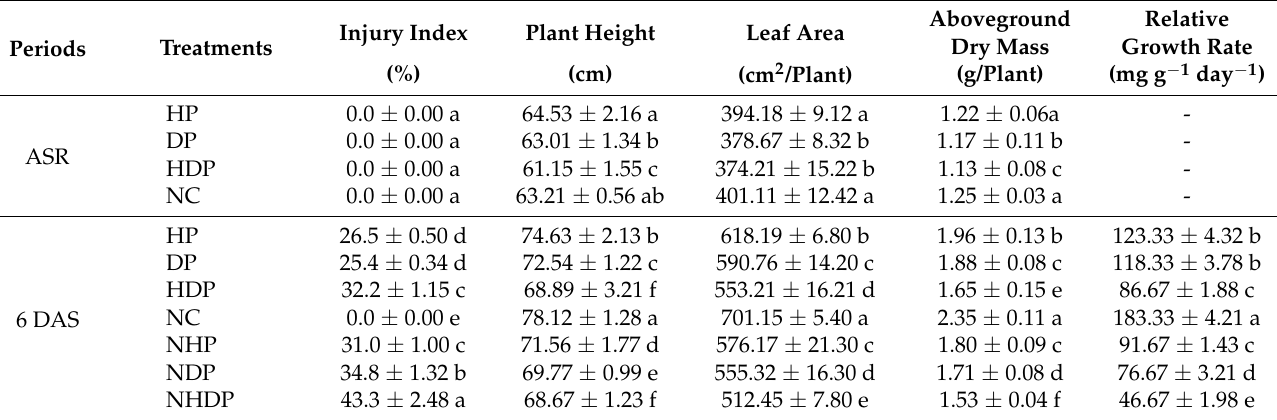
Table 1. Effects of stress priming on the injury index and aboveground growth traits of seedlings under stress